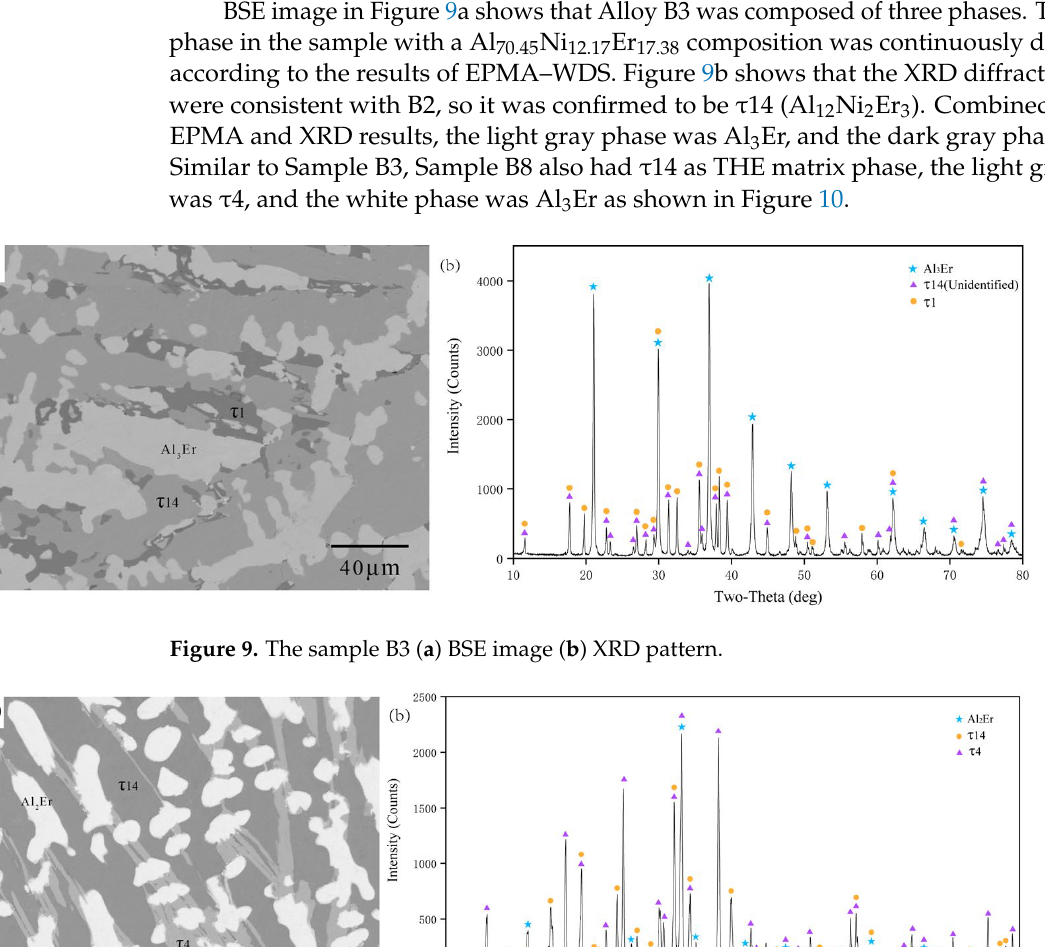
Figure 8. Sample B2’s ( a ) BSE image and ( b ) XRD pattern.